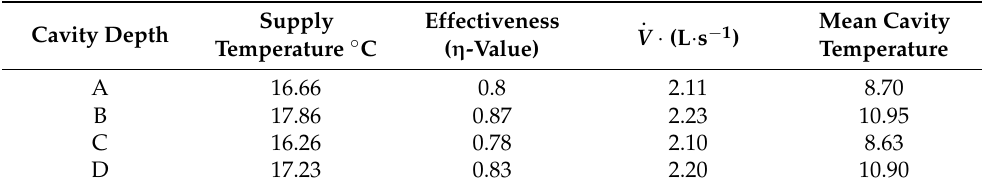
Table 8. Supply air temperature, volumetric flow rate for the simulated scenarios. Cavity